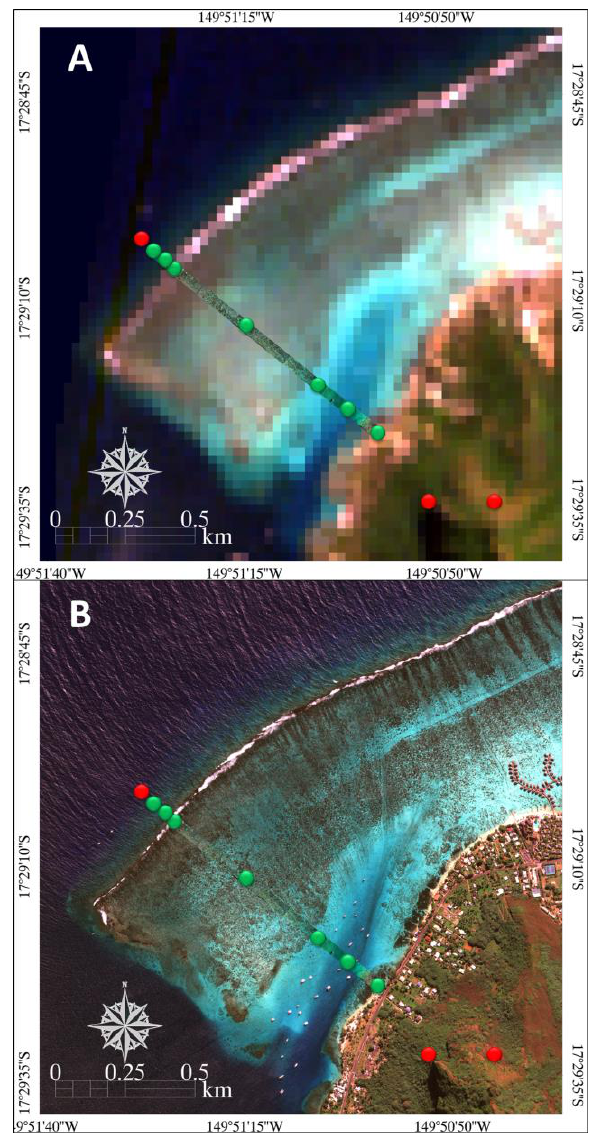
Figure 2. Natural-coloured (A) Hyperion (30 m × 30 m) and (B) WorldView-3 (0.3 m × 0.3 m) imageries of the study site in Moorea Island (French Polynesia), over which is draped the unmanned aerial vehicle natural-coloured Mavic Pro imagery (0.1 m × 0.1 m). Green and red points represent geolocations of the classes investigated, provided with and deprived of